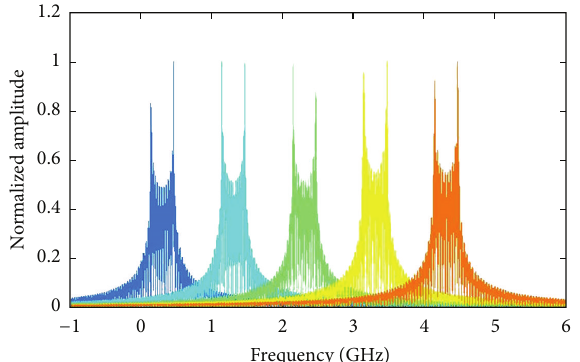
Figure5:SpectrumofOFDMmultibandsignalwith 𝑀 = 5 carriers.